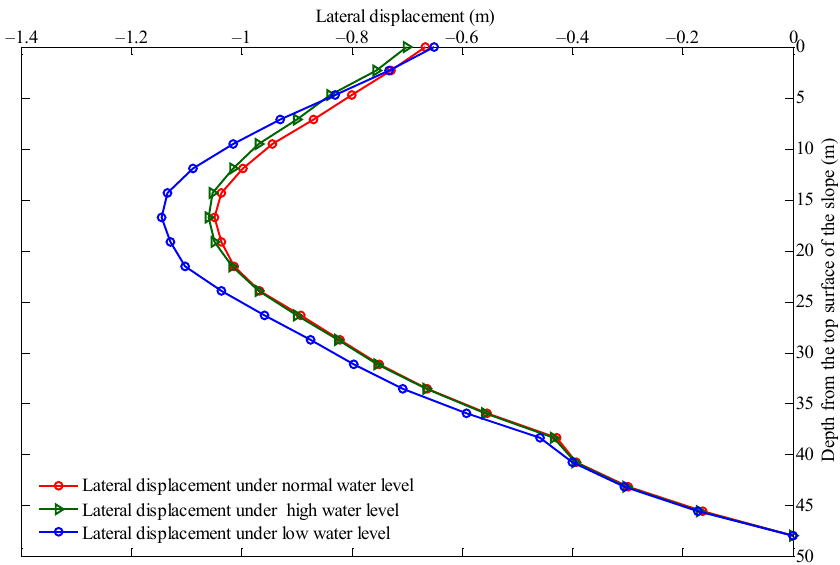
Figure 9. The depth-dependent lateral displacement of the riverbank slope under different water levels.